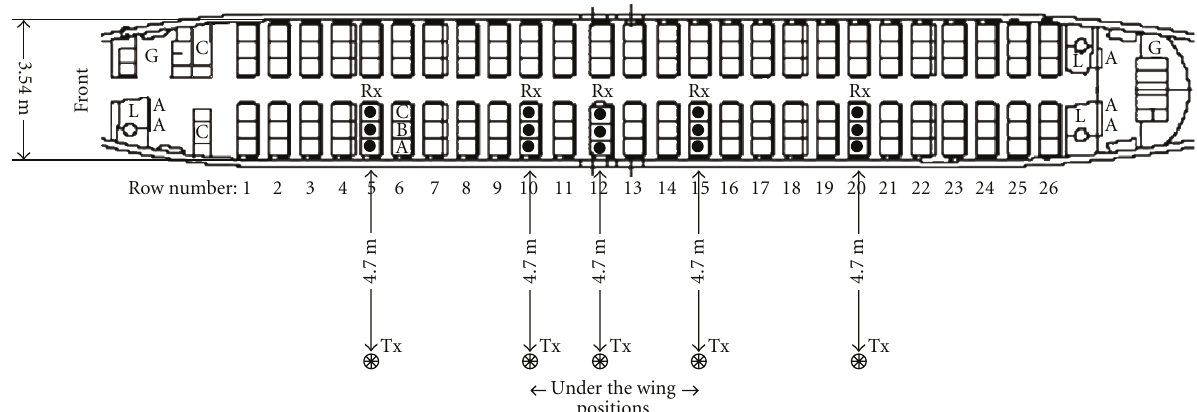
Figure 4: Ground plan of the attenuation measurement